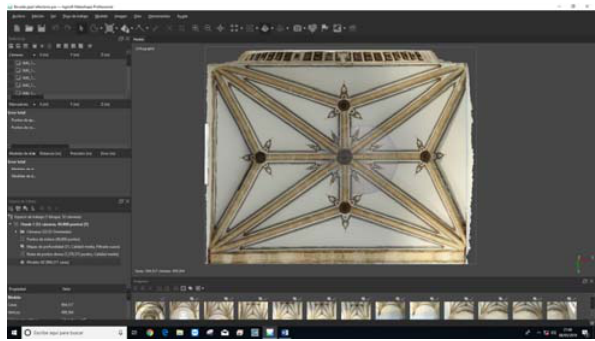
Figure 6: Model 3D in Agisoft